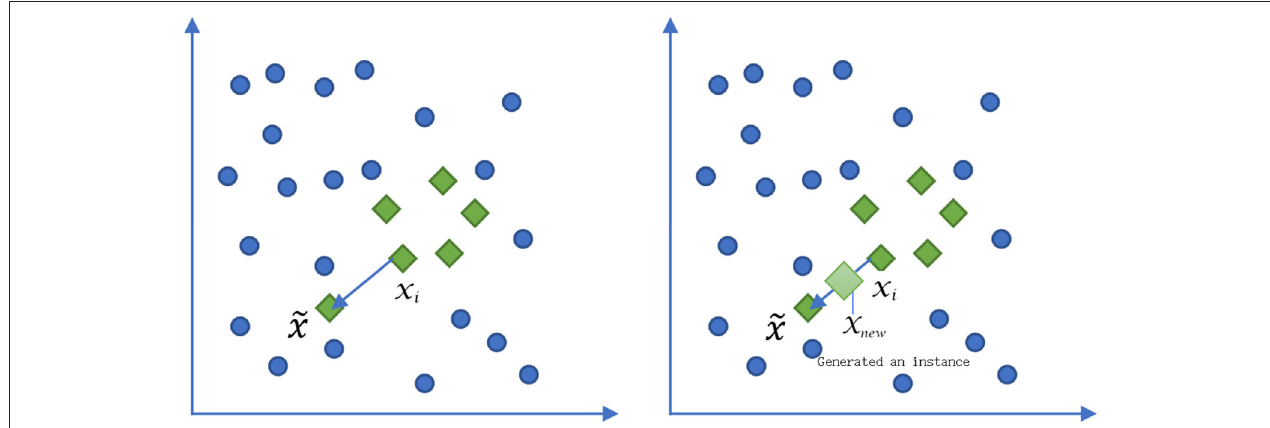
FIGURE 1 | The diagram of Borderline-1 Smote algorithm to deal with the data balancing between death and survival. x i represented a minority sample of death. ˜ x was an adjacent sample of the selective minority sample. x new was a sample between the x i and ˜ x